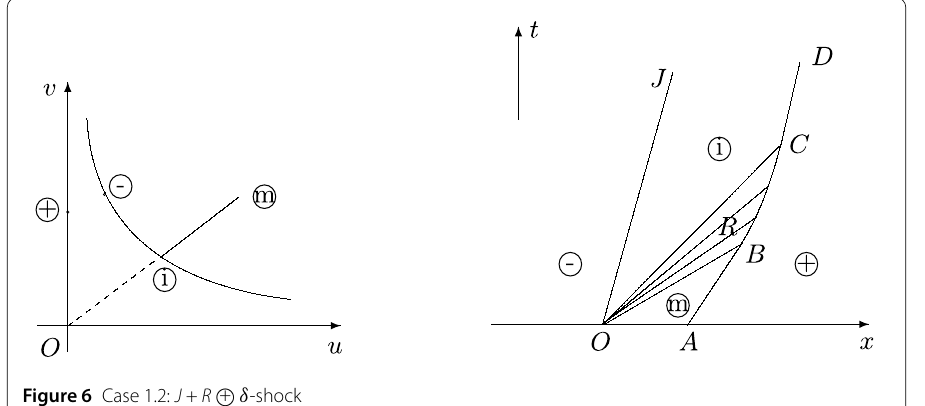
Figure 6 Case 1.2: J + R + (cid:10) δ